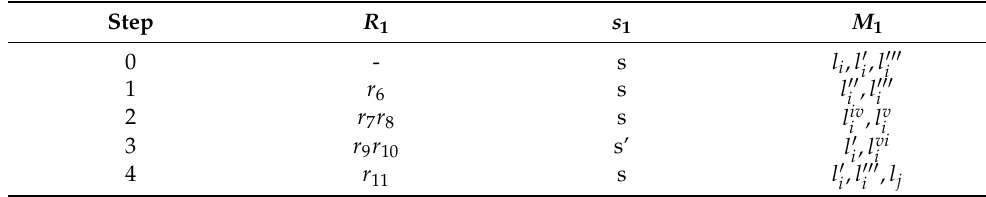
Table 3. The application of rules in R 1 , the evolution of channel states s 1 , and the rewriting of multisets M 1 in membrane 1. During the simulation of a SUB instruction l i :( SUB ( r ) , l j , l k ) with register r not empty.